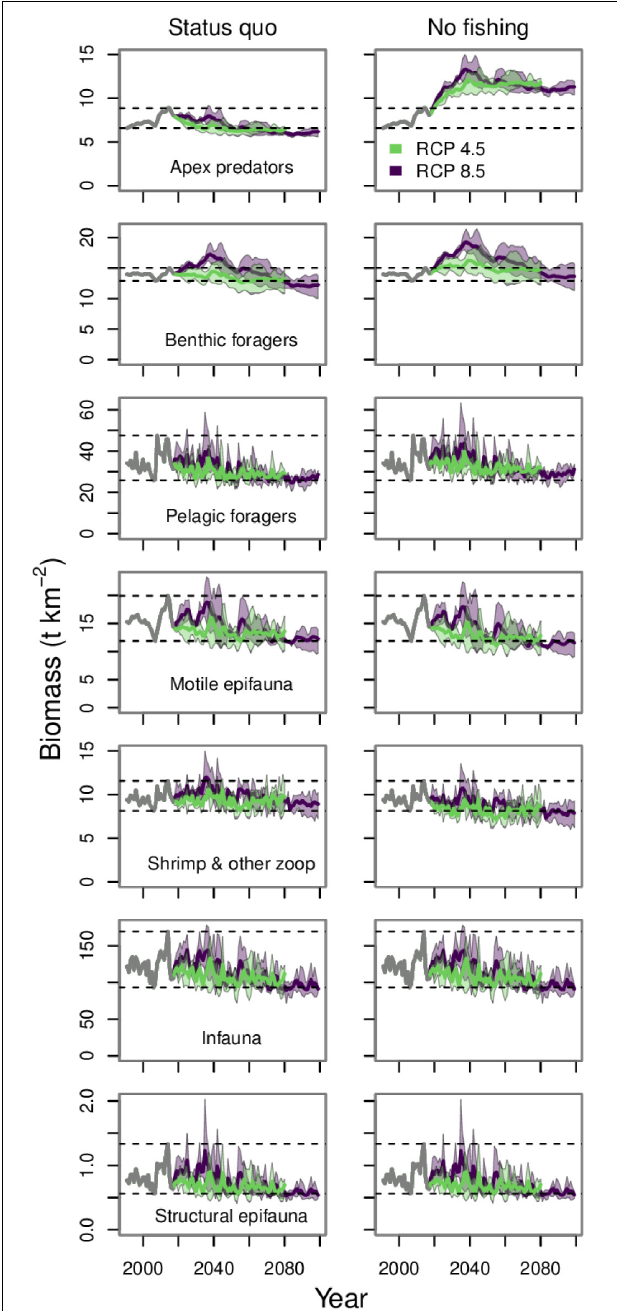
FIGURE 9 | Biomass projections for trophic guilds under the status quo and no fishing scenarios. The gray lines from 1991 to 2017 indicates the historical period. The purple and green polygons indicate the minimum and maximum range for the three earth system models run under each RCP. The purple and green lines indicate the mean of the three runs for each RCP. The dashed lines indicate the minimum and maximum values from the historical period.